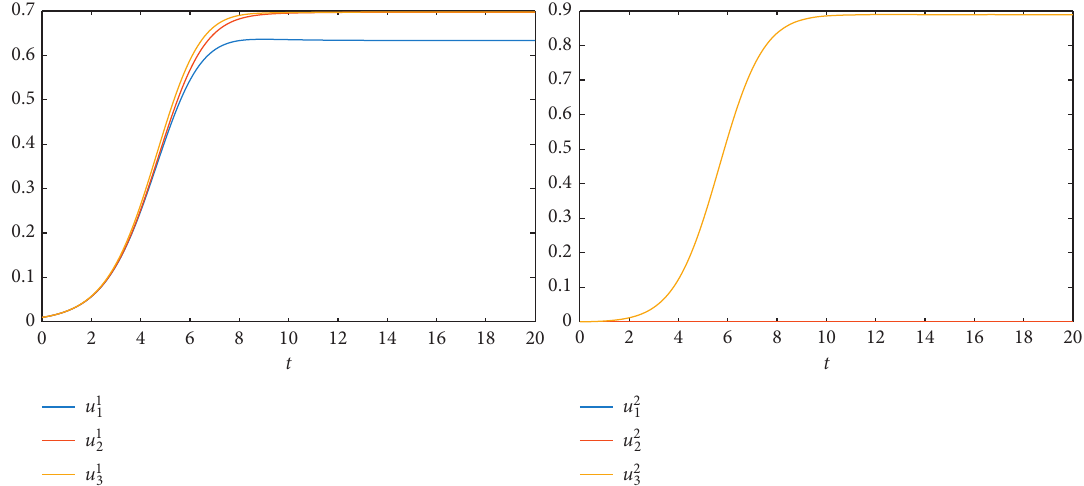
Figure 4: Simulation of (43) with (40) by fixing ( d